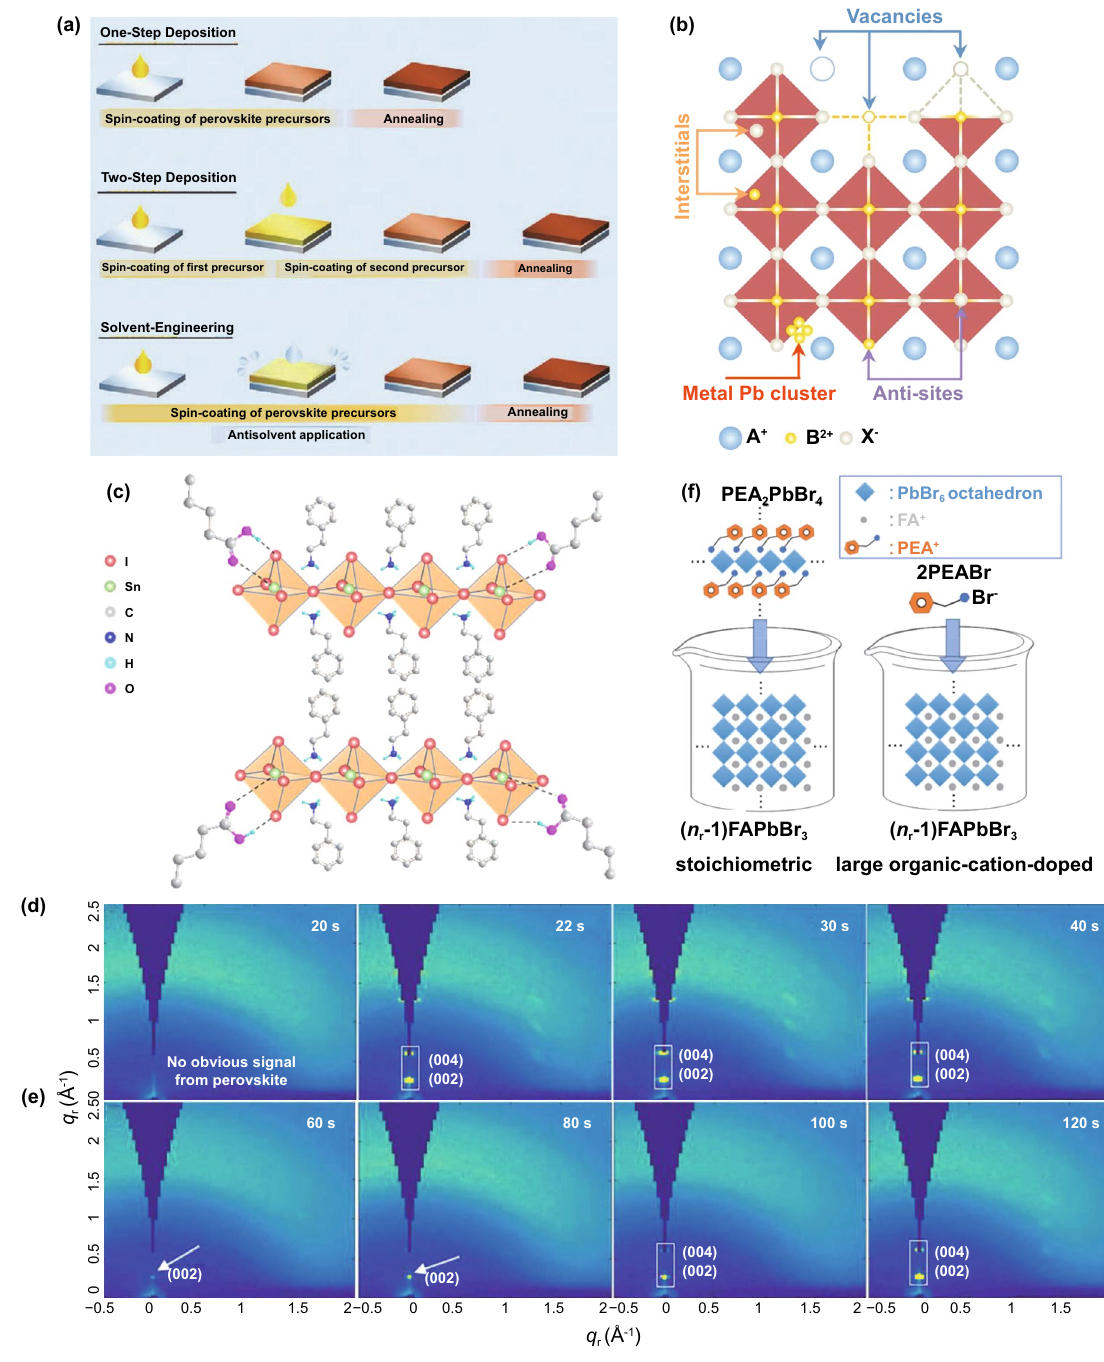
Fig. 8 a Schematic diagram of perovskites deposition by solution processing. Copyright 2020 Wiley–VCH Verlag [107]. b Defects of perovs- kites include vacancies, anti-sites, interstitials and metal clusters. Copyright 2020 Springer Nature [71]. c Diagram of hydrogen bonding and coordination bonding interactions between VA and PEA 2 SnI 4 crystals. In situ GIWAXS measurements of spin-coated PEA2SnI4 d without and e with VA at different times. Copyright 2020 American Association for the Advancement of Science [114]. f Illustration of perovskite precursor solutions prepared by controlling stoichiometry and adding organic ammonium salts. Copyright 2020 Wiley–VCH Verlag